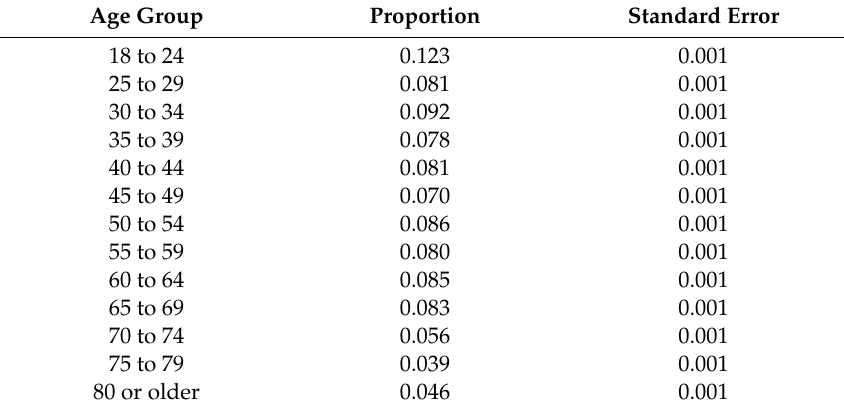
Table 4. Variable AGE5YR: “Fourteen-Level Age Category [20]”.